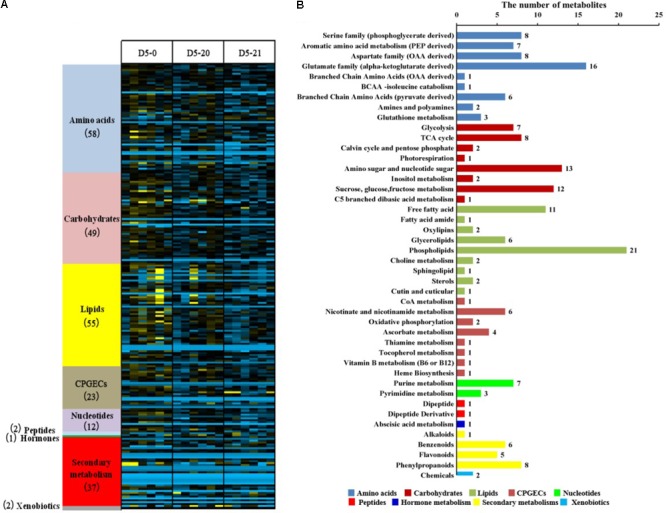
Distribution of identified metabolites in the cambium of non-transgenic and transgenic poplar. (A) Heat map showing the clustering of detected metabolites into nine classes across the three lines. Different colors represent nine metabolic pathways of the 239 metabolites, and the numerals in parentheses represent the numbers of metabolites identified in the primary metabolic pathways. (B) The distribution of metabolic pathways of the differential 197 metabolites. Ordinate reports the various metabolic pathways, while abscissa represents the number of metabolites. Different colors represent primary pathways.